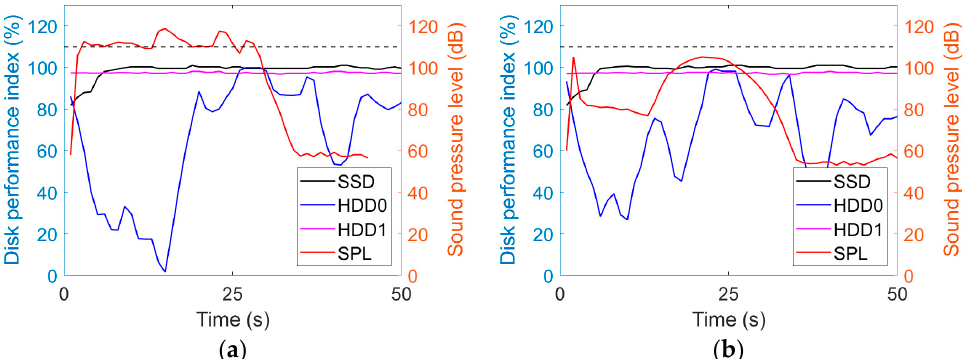
Figure 10. SPL and disk performance index as a function of time throughout FK-5-1-12 discharge by ( a ) standard and ( b ) silent nozzle for low ceiling applications with 6 mm orifice diameter.